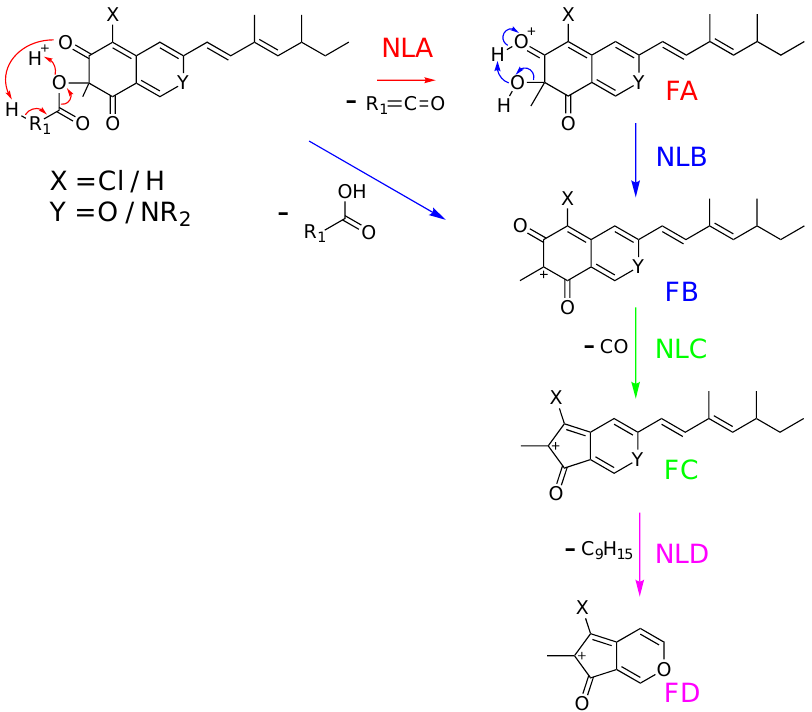
Figure 4. Proposed fragmentation pathway of molecules in clusters A and B. Depending on R 1 , X and Y elements. NL = neutral loss, F = fragmentation (below).